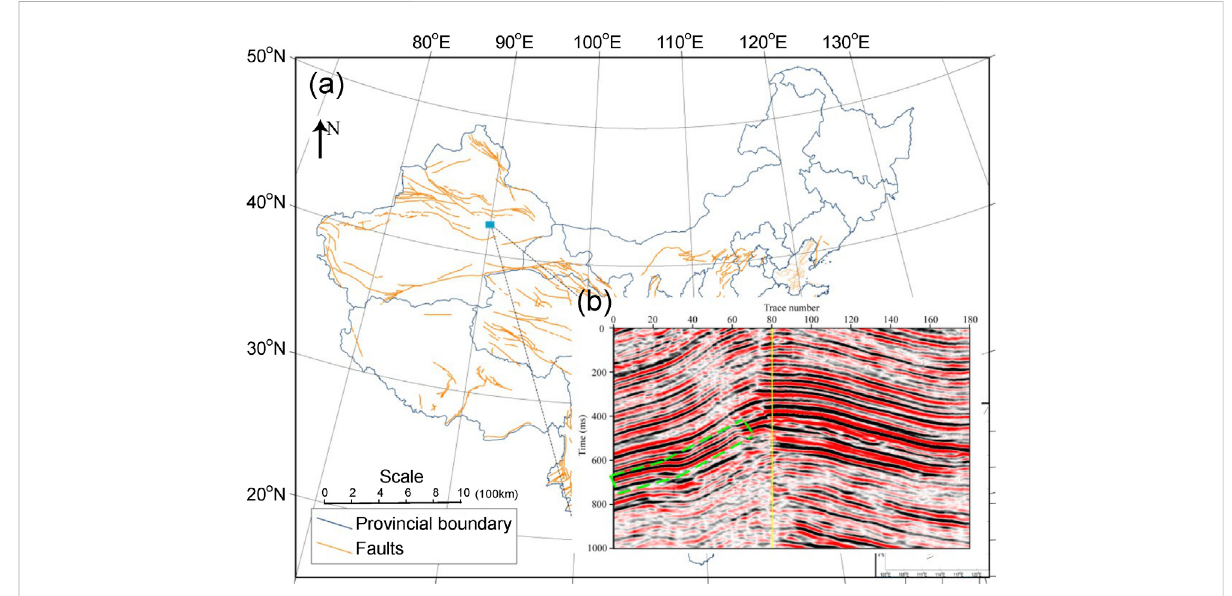
FIGURE 6 Location of the real seismic data. (A) Location of the exploration area where data were collected (blue square). This is created by using the Generic Mapping Tools (GMT) 4, accessed on 1 May 2022; (B) original pre-stack time migration pro fi le of a through-well line from 3-D seismic data; the yellow vertical line represents extracted single-channel seismic data for subsequent analysis; the green box indicates a reservoir by drilling